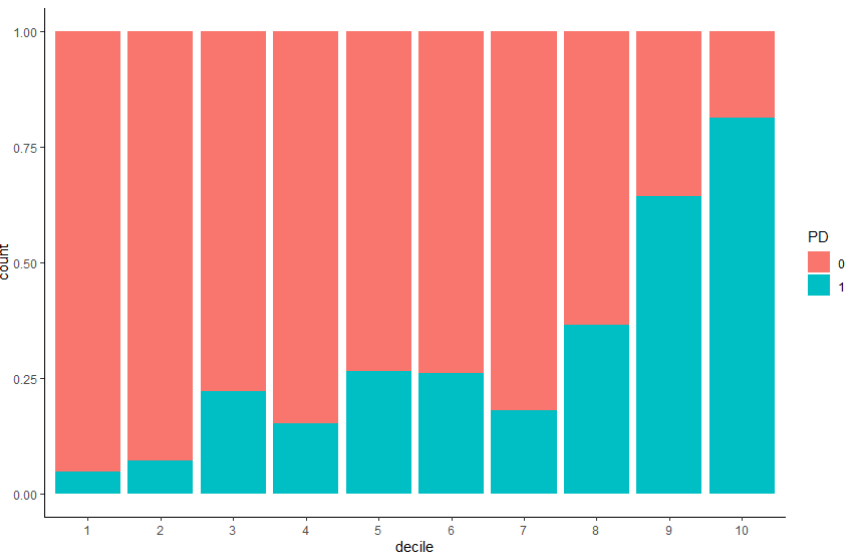
Figure 2. Cases and controls distribution in deciles using the multivariate model before imputation. The distribution of cases and controls are described in blue and orange, respectively.